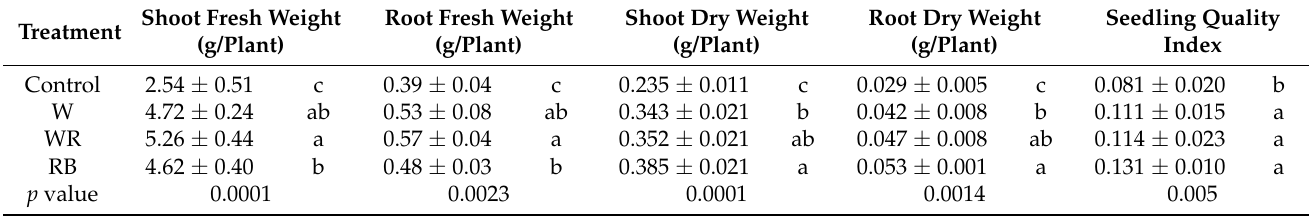
Table 4. Growth of the greenhouse-grown tomato seedlings grown under supplementary white LEDs, white plus red LEDs, and red plus blue LEDs, respectively, and tomato seedlings grown under sunlight only were regarded as the control.